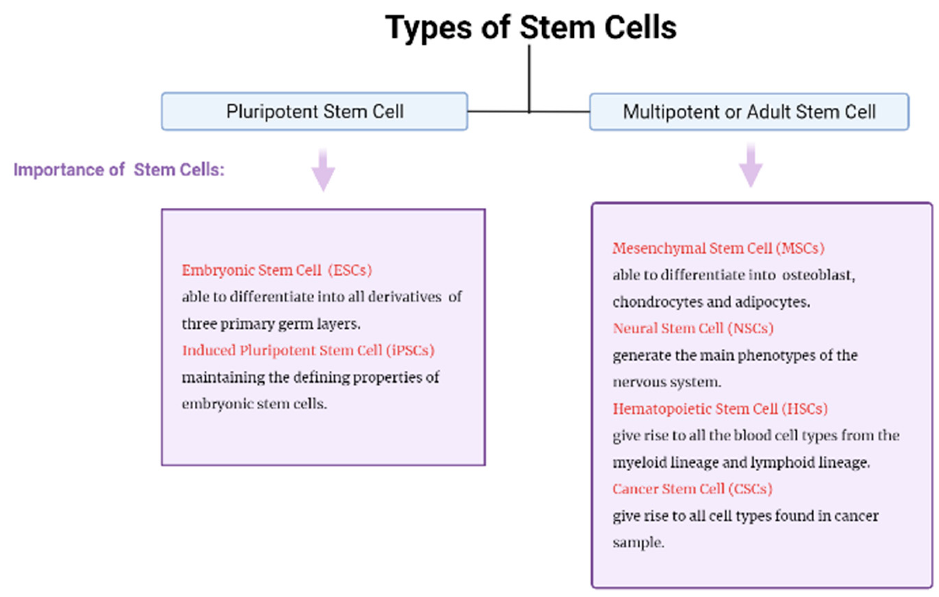
Figure 1. The types of stem cells and their importance.